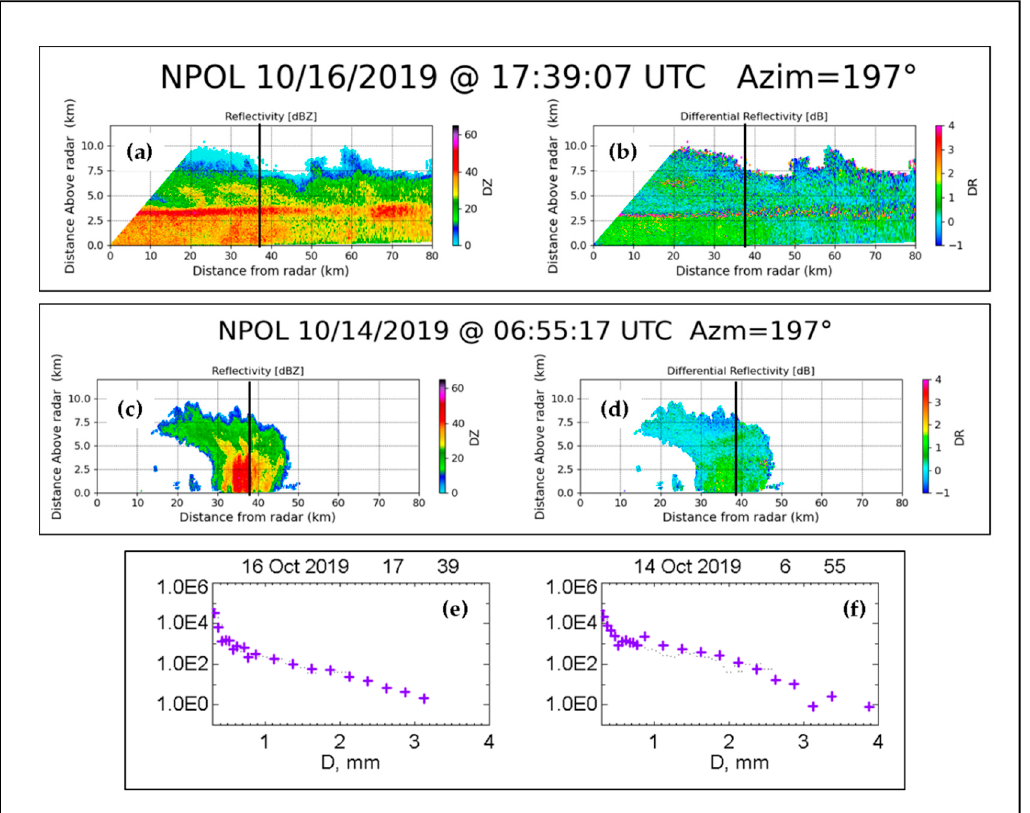
Figure 2. ( a ) RHI (range-height indicator) scan of Z h and ( b ) Z dr during a stratiform rain event on 16 October 2019. ( c , d ) RHI scans of Z h and Z dr during a convective rain event on 14 October 2019. ( e ) 1 min composite drop-size distributions (DSD) from disdrometers for the stratiform event in case ( a ), and ( f ) 1 min DSD for convective rain in case ( c ). The vertical black lines in the RHI scan correspond to the range of (and height above) the disdrometers.